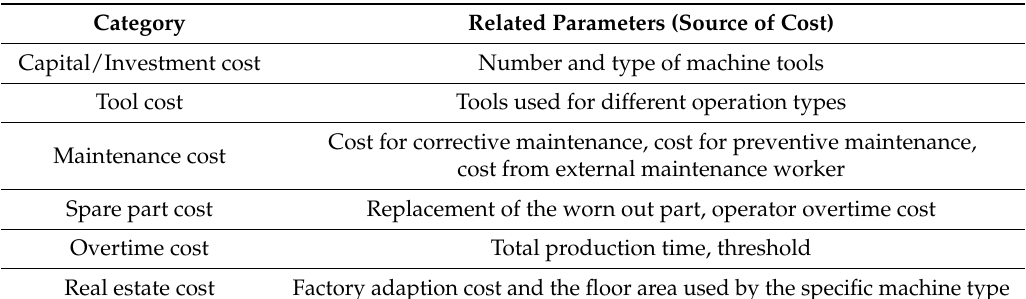
Table 1. Basic costs considered in the